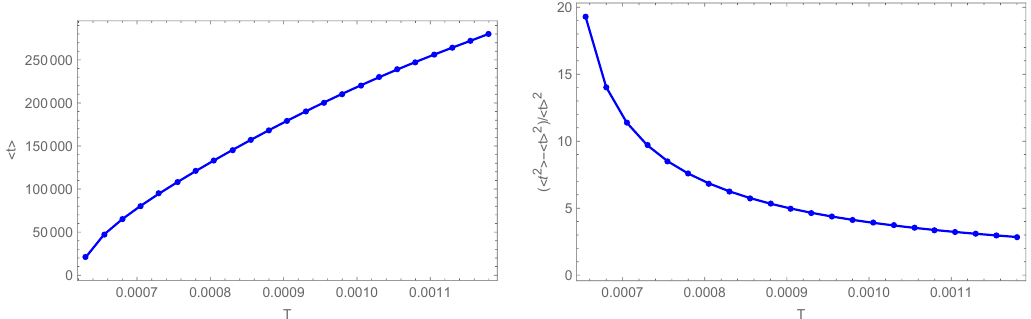
Figure 11 . Mean first passage time (left panel) and the relative fluctuation (right panel) of the transition process from the two black hole phase to the unstable wormhole phase. In this plot, q = 50 , J = 1 , and ˆ µ = 0 . 1